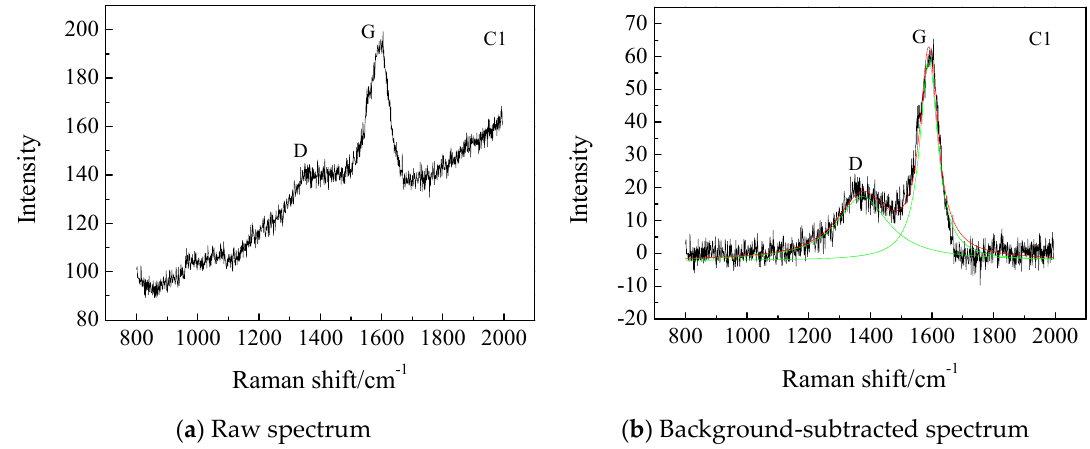
Figure 2. A typical room-temperature Raman spectrum of one of the tested coals, C1.